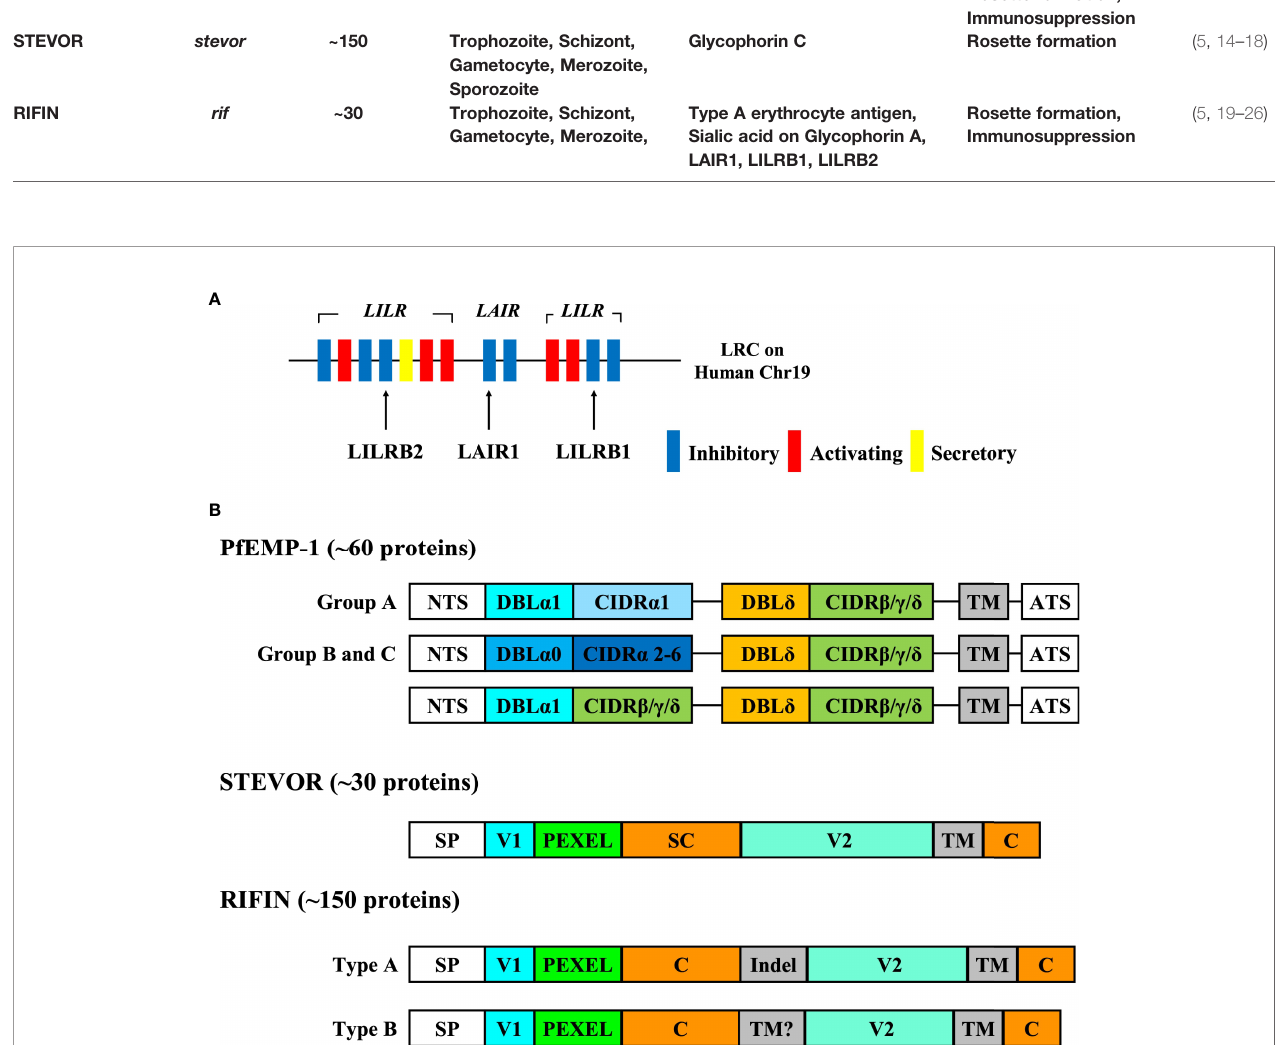
FIGURE 1 | The genomic location of inhibitory immune receptors and the structure of VSAs. (A) The genomic location of inhibitory immune receptors. Inhibitory immune receptors are located in the leukocyte receptor complex (LRC) region on human chromosome 19q13.4 in tandem. LRC region contains a number of immunoglobulin-like receptors such as leukocyte immunoglobulin like receptors (LILRs) and leukocyte associated immunoglobulin-like receptors (LAIRs). Each of these receptors forms a multiple gene family, and LILR family consists of fi ve inhibitory receptors (LILRB1-5), fi ve activating receptors (LILRA1, 2, 4-6) and one secretory form (LILRA3). It is thought that activating receptors have evolved from inhibitory receptors to overcome pathogens because some inhibitory receptors such as LILRB1 and LAIR1 are exploited by pathogens in their immune evasion mechanisms.. (B) The structure of VSAs. PfEMP-1 proteins are divided into groups (A-C) based on chromosomal location and the direction of transcription. The extracellular region of PfEMP1 is composed of the combination of a Duffy binding-like domain (DBL a - z ) and a cysteine-rich interdomain region (CIDR a - d ) depending on the organization and the length. This fi gure shows the typical structure of group (A-C) PfEMP-1. The larger PfEMP1 proteins have additional DBL domains between DBL and CIDR domains. PfEMP-1 can bind to molecules such as CD36, intercellular adhesion molecule-1 (ICAM-1), and endothelial protein C receptor (EPCR) via its CIDR and DBL domains. RIFIN is divided into type A and type B RIFIN, and type A RIFIN contains a 25 amino acid sequence inserted at the N-terminus (Indel) that is not present in type B RIFINs. RIFIN interacts with immune receptors via its variable region (V2).